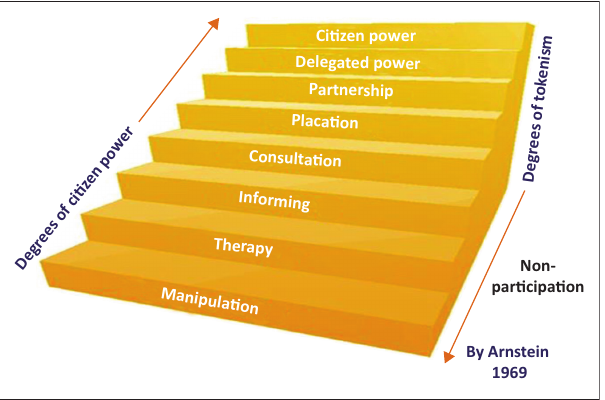
FIGURE 2 : Ladder of citizen